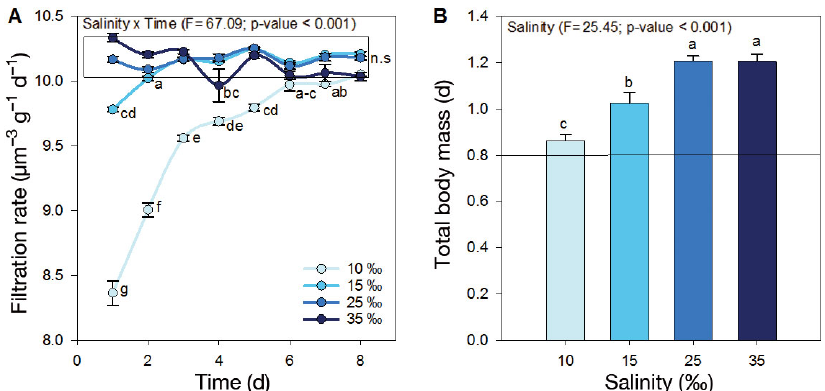
Fig. 3. (A) Filtration rate of Pacific oysters Crassostrea gigas during acclimation to salinity. (B) Body mass of oysters as a function of salinity after 11 d of acclimation (Expt 1). Data are means ± SE between replicates (n = 6). Letters indicate significant differences. Filtration rate was log ( x +1)